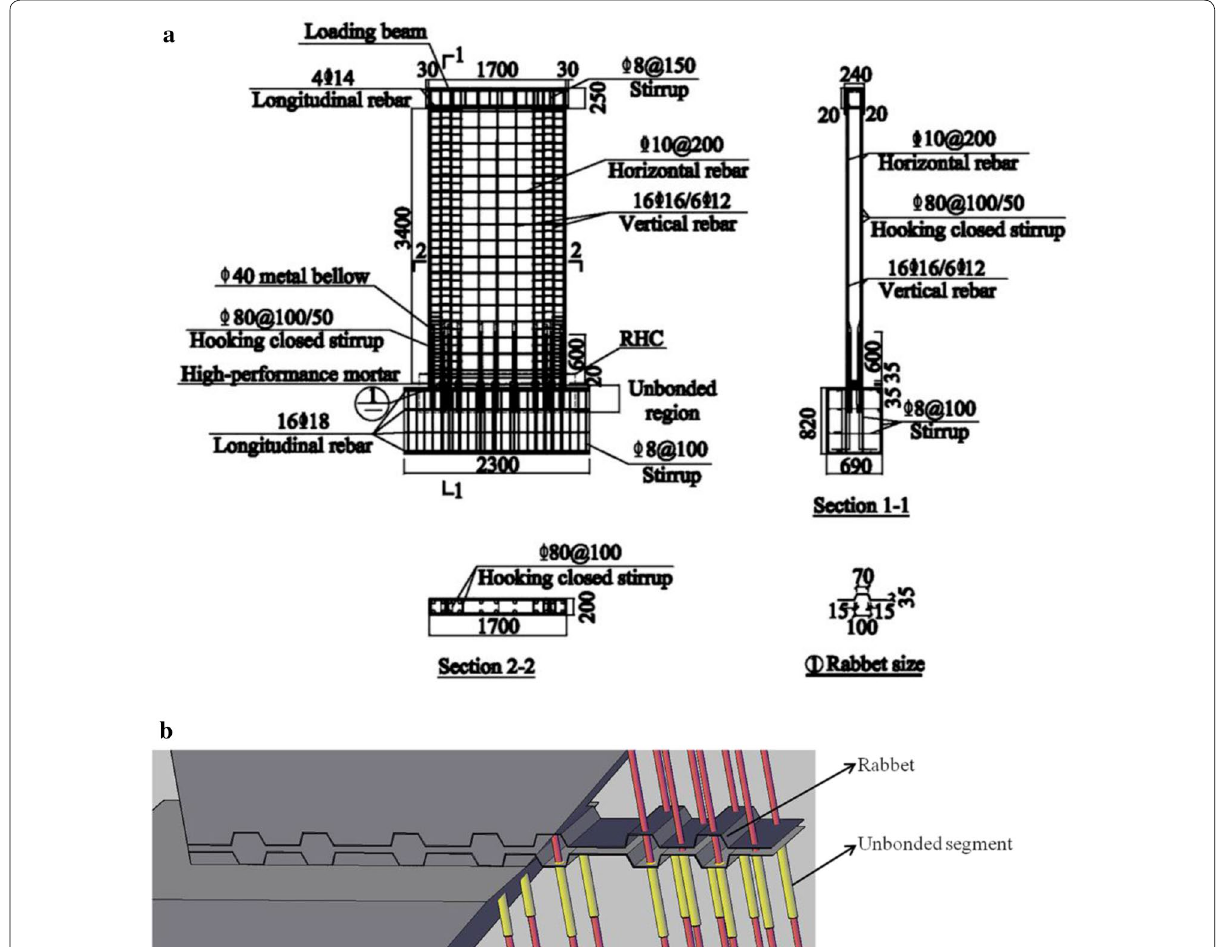
Fig. 2 a Dimension and rebar details of test specimen in millimeters and b connection